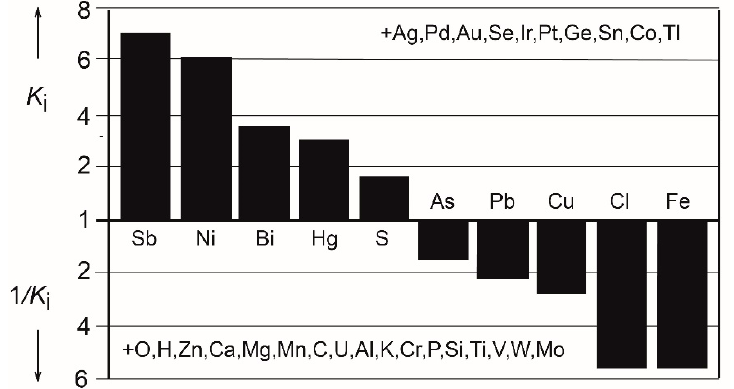
Figure 3. The species-defining elements ( N ) of three groups of Te minerals and the concentration coefficient K i = O-free/O-bearing (see Table 2).